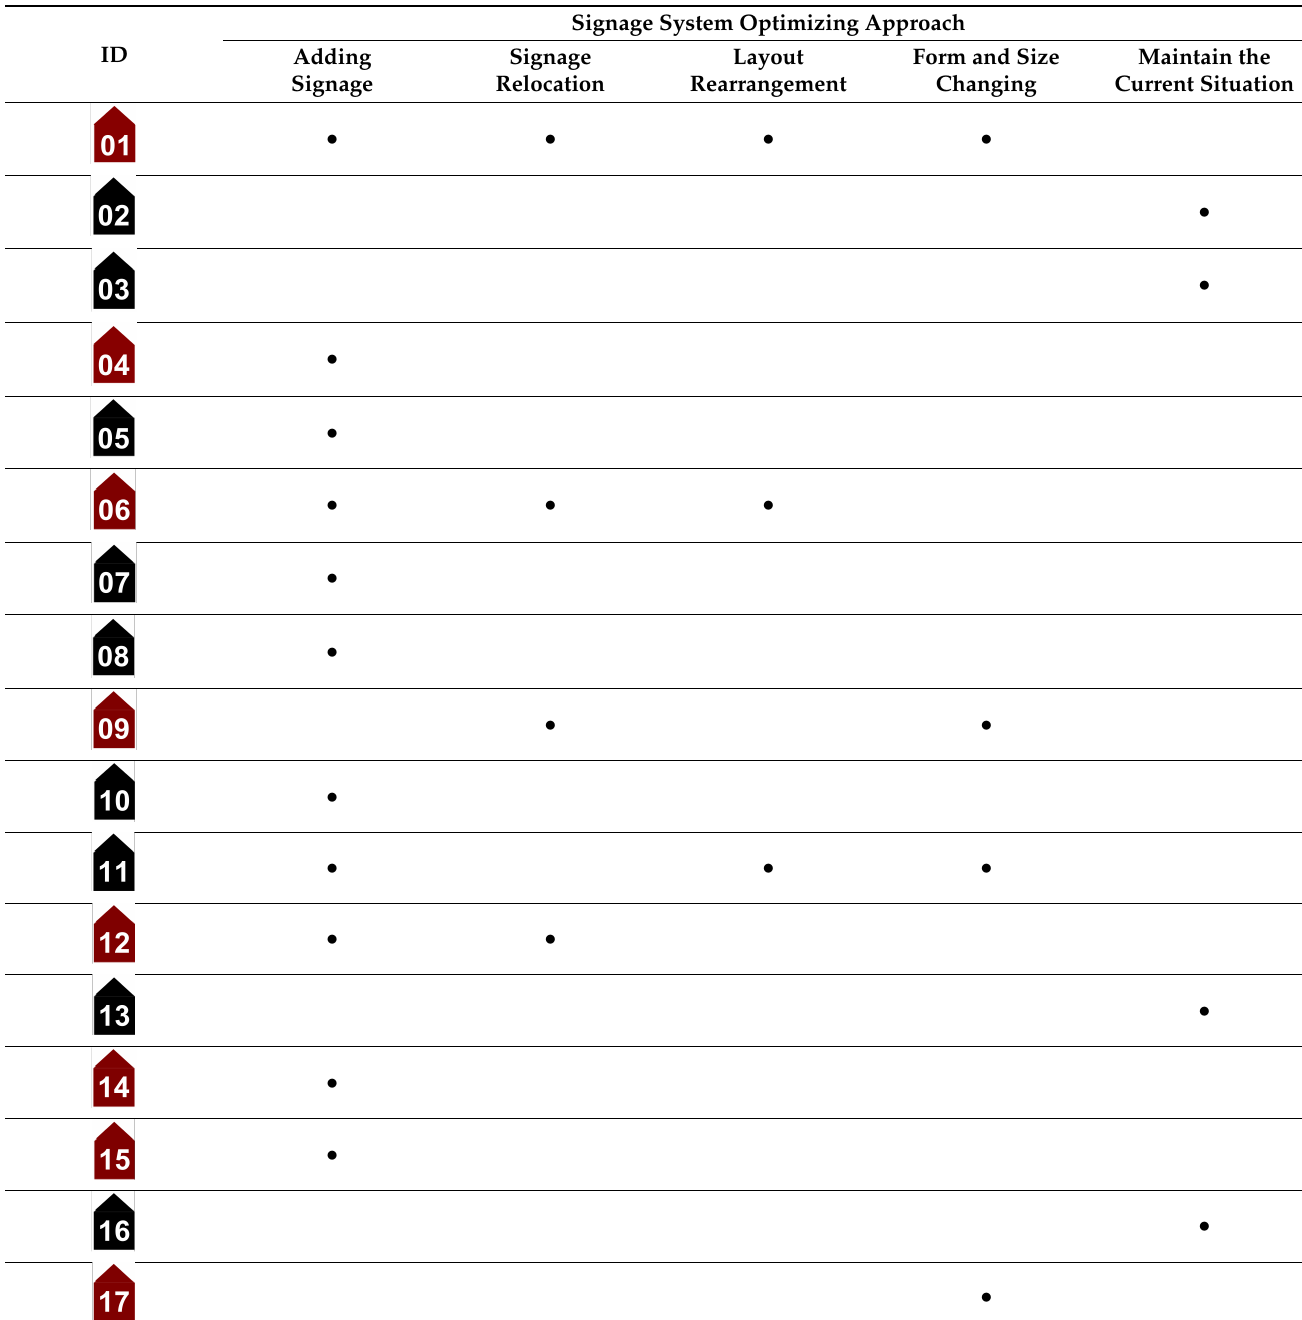
Table 24. Approaches for optimizing signage system on wall surfaces.